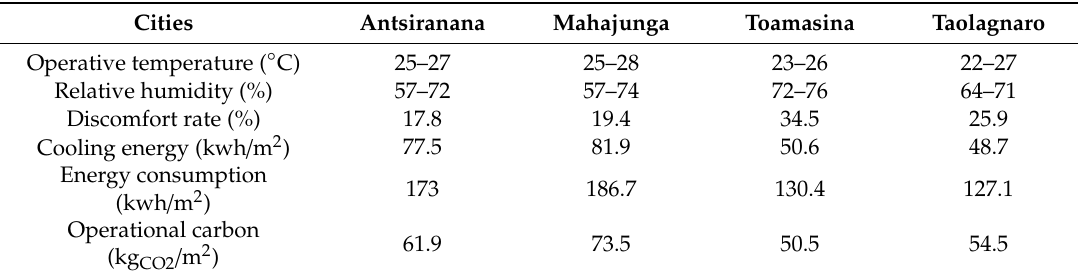
Table 3. Some characteristics of indoor building